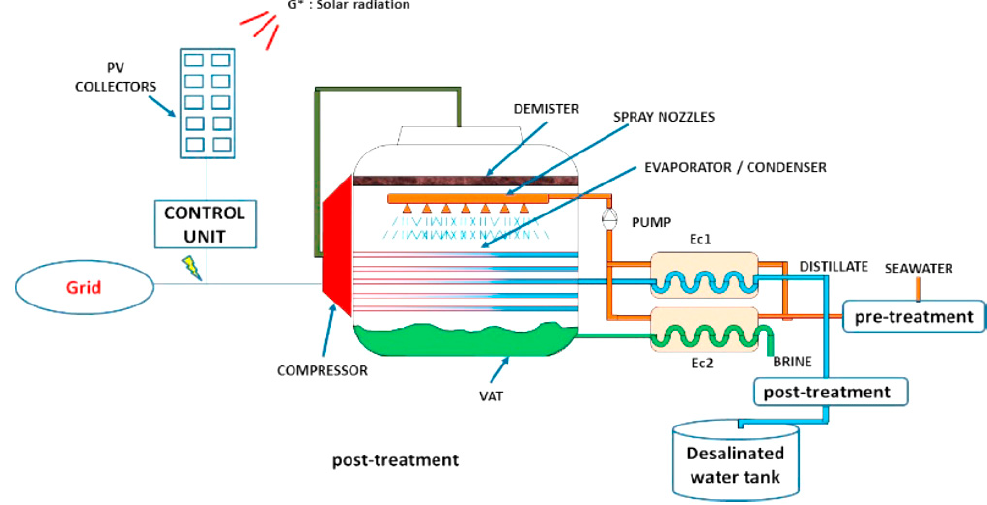
Figure 10. Vapor Compression Distillation system Figure10. Vapor Compression Distillation system [81].